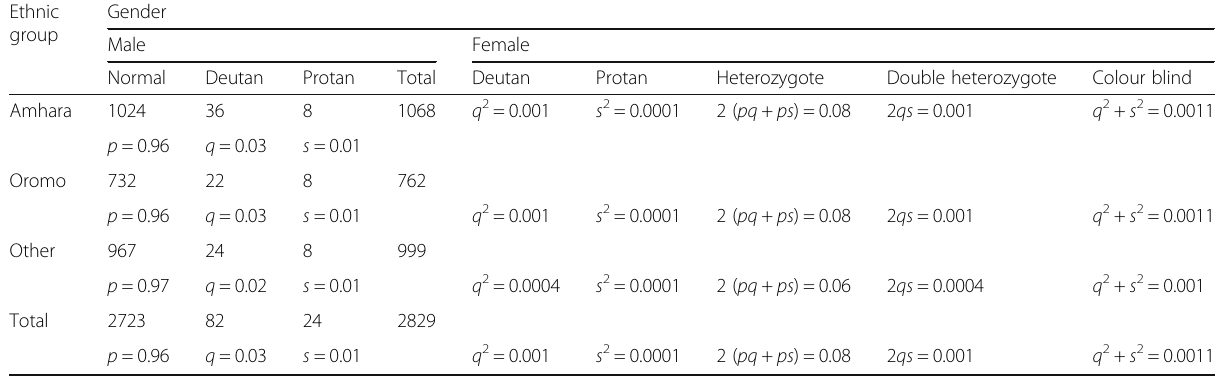
Table 3 The frequencies of normal, heterozygote, double heterozygote and colour blind male and female subjects Ethnic